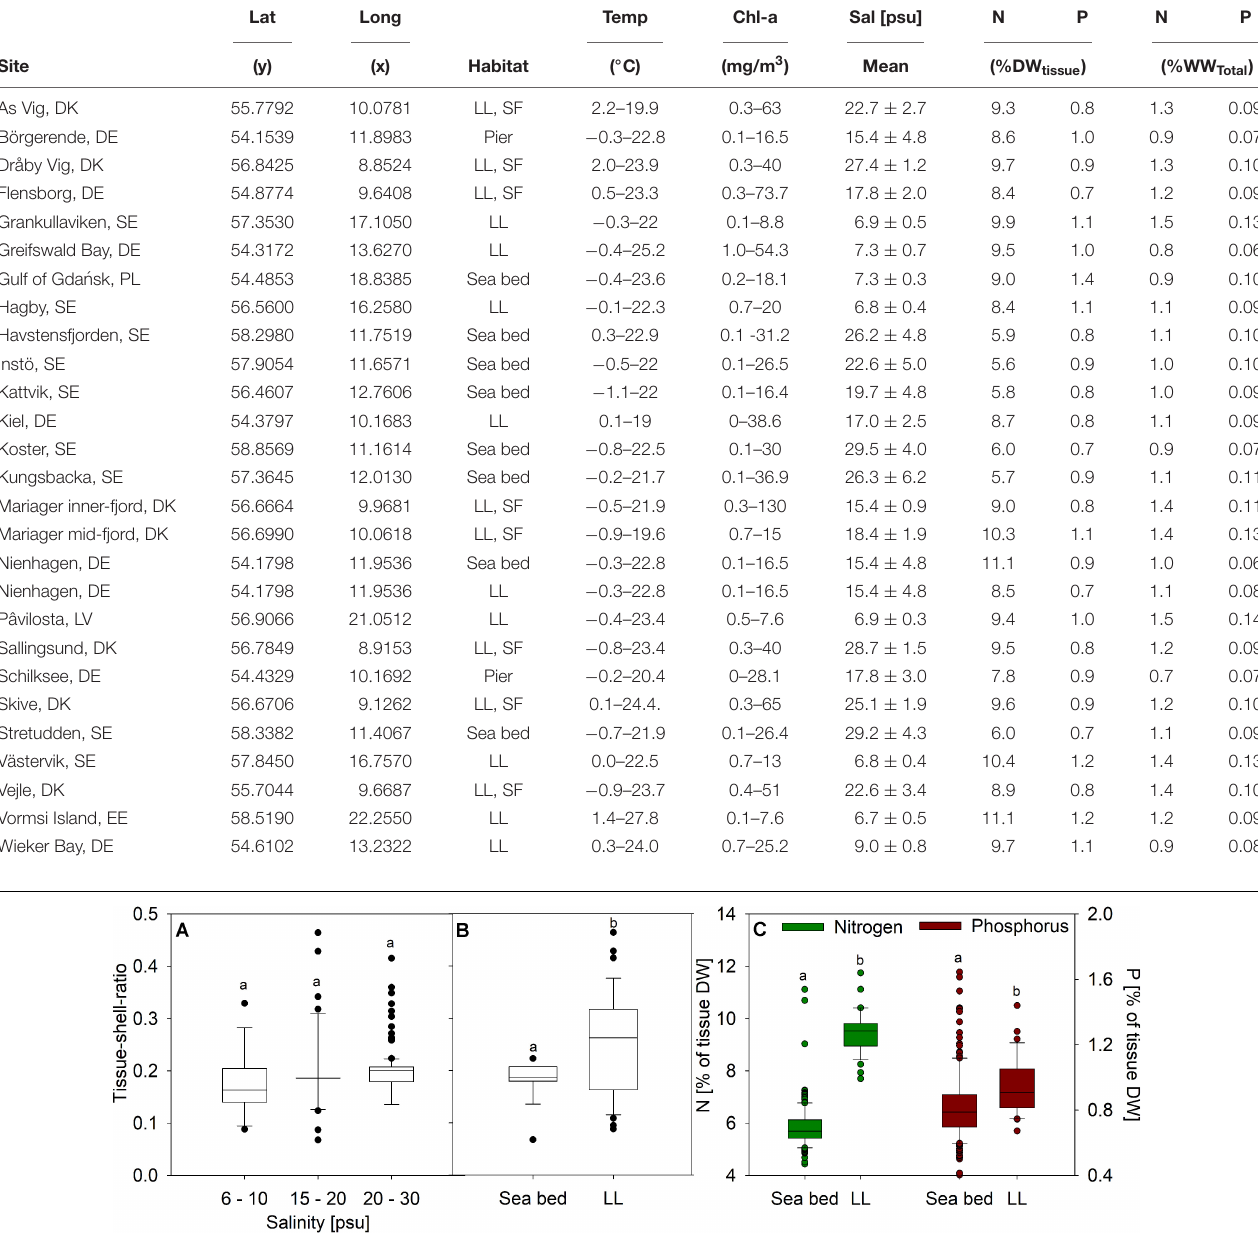
FIGURE 2 | Ratio of dry tissue to shell in regards to (A) salinity and (B) habitat of the mussel as well as (C) nitrogen and phosphorus content in dry tissue of mussels from the sea bed and cultivated on longlines (LL).